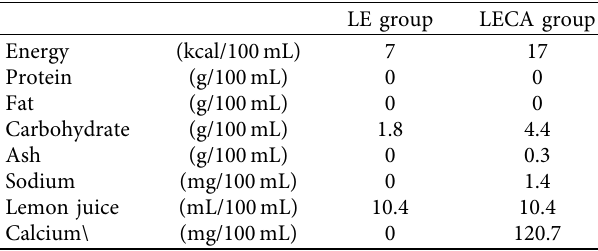
Table 1: Test beverage